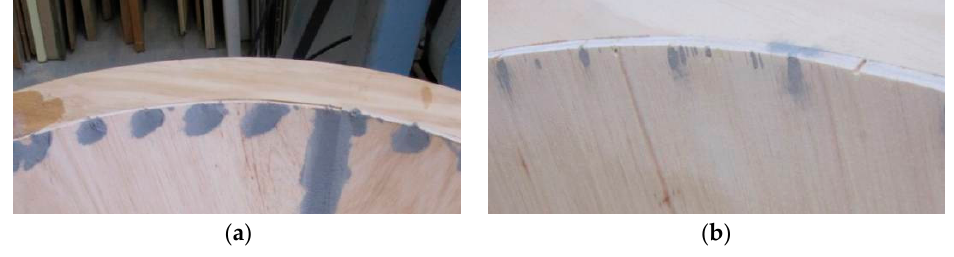
Figure 5. Poly filler ( a ) before sanding; ( b ) after sanding.